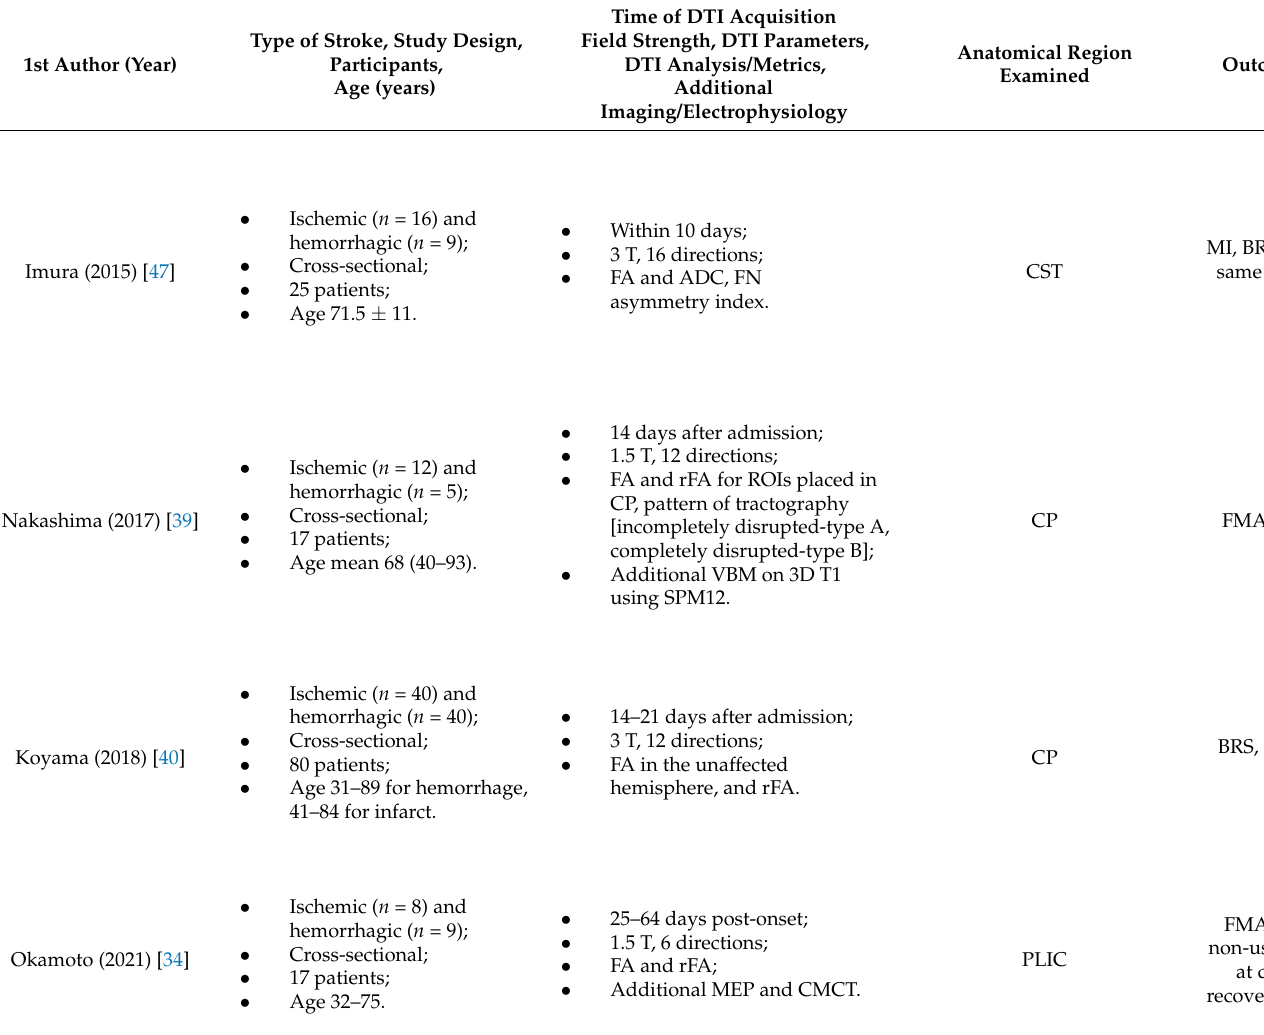
Table 3. Basic characteristics and main findings of studies including patients with both ischemic and hemorrhagic